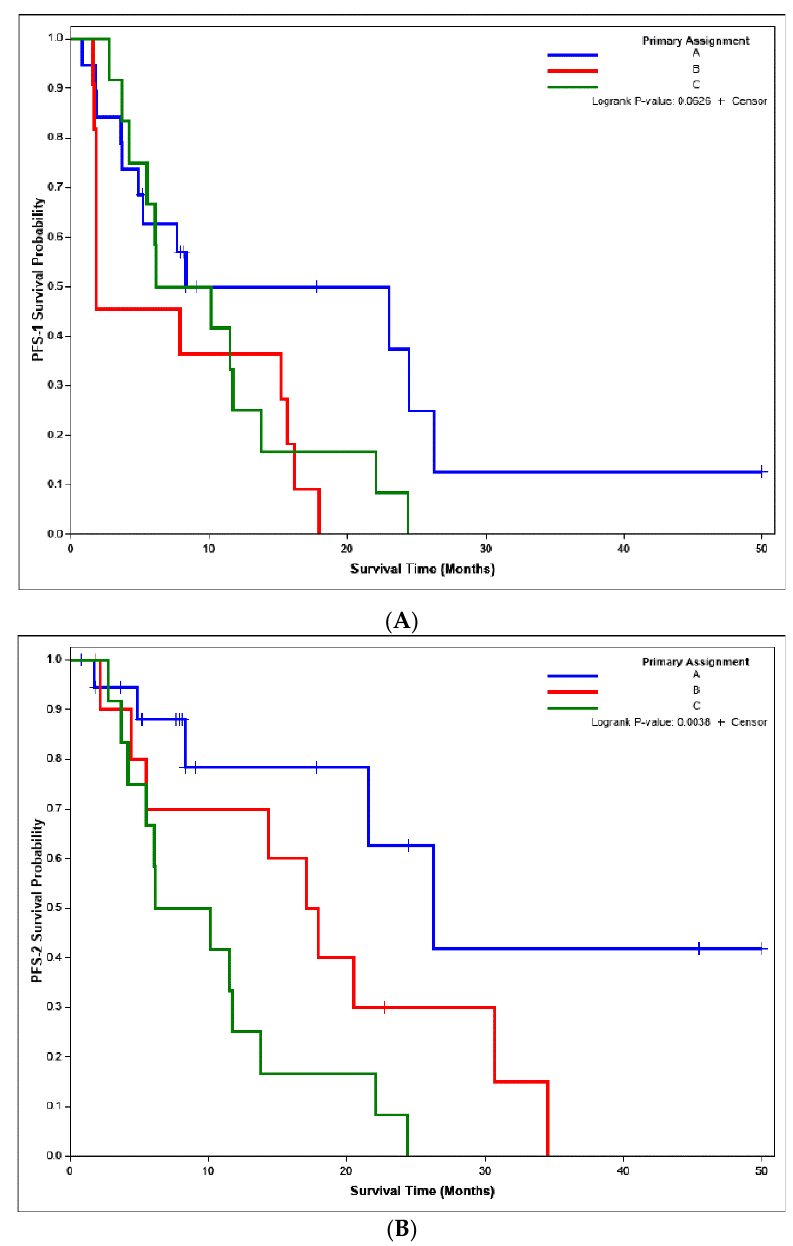
Figure 3. Comparison of PFS between the three arms of the study. ( A ). PFS1 from treatment initiation until initial progression of disease or death; ( B ). PFS2 calculated across initial and second disease progression while on combination treatment or death. Comparable median PFS1 for Arms A and C at 8.3 and 8.1 months but only 1.8 months for Arm B. The 1 ‐ year PFS1 rate was 49.9% (25.2%, 70.4%) for arm A but below the prespecified efficacy threshold of 50% for arm B at 36.4% (11.2%, 62.7%), and arm C at 25.0% (6.0%, 50.5%). PFS2 was significantly prolonged in arms A and B in comparison to arm C. Median PFS2 was 26.3 (8.3, NA) months for arm A and 17.5 (2.1, 30.7) months for arm B but only 8.1 (3.7, 13.8) months for patients on arm C. The 1 ‐ year PFS2 rate was also higher at 78.4% (44.9%, 92.8%) and 70.0% (32.9%, 89.2%) for arm A and B, respectively, compared to 25.0% (6.0%, 50.5%) for Arm